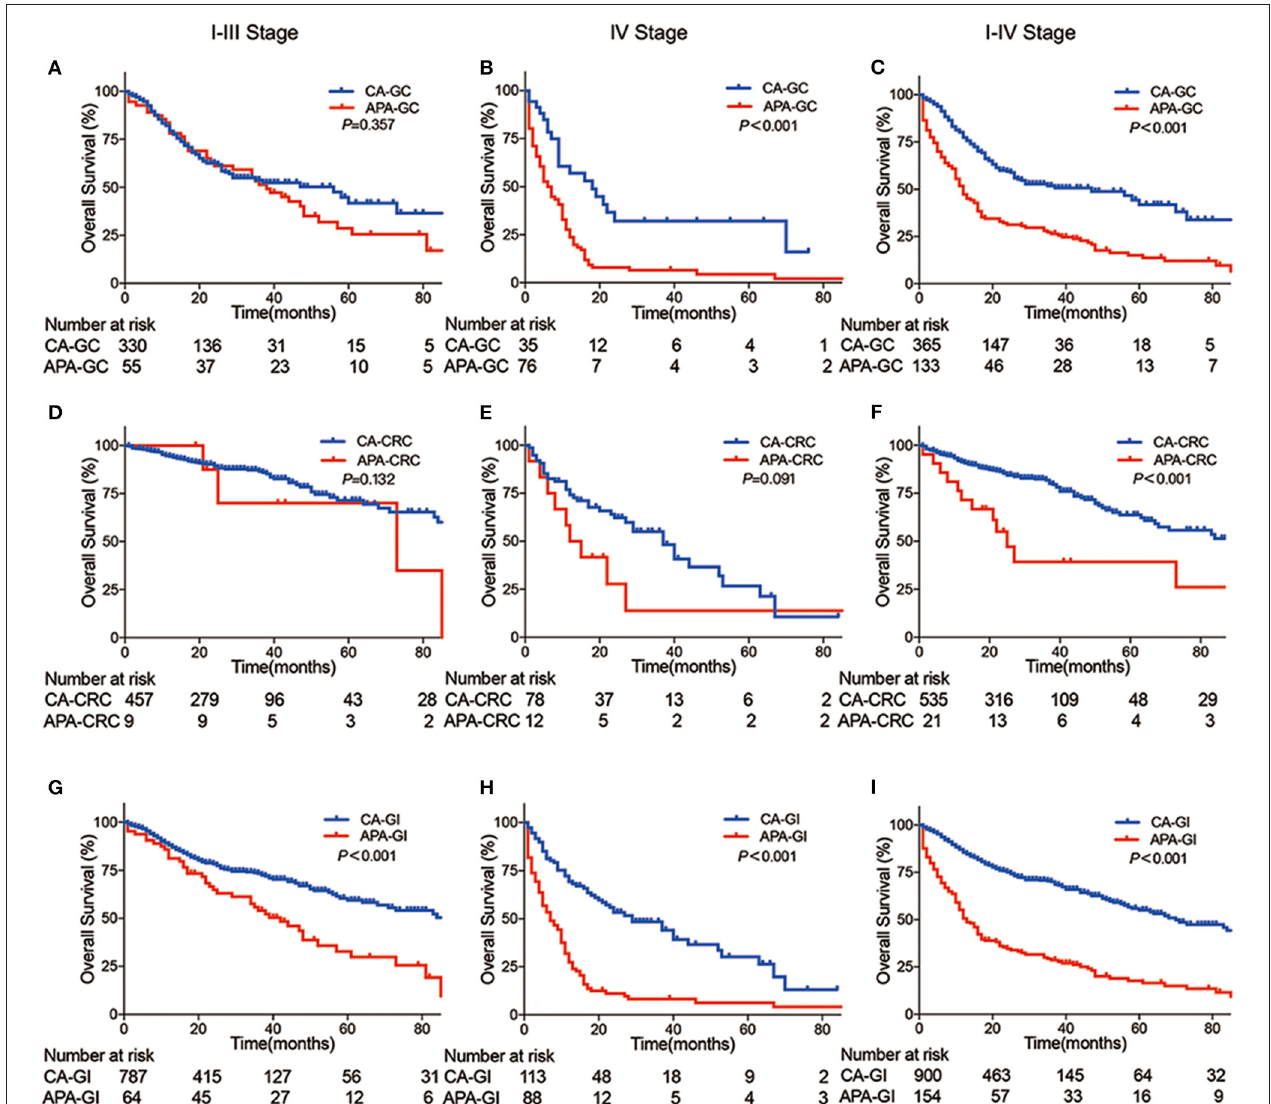
FIGURE 2 | Kaplan–Meier curve between APA-GI and CA-GI. (A–C) Survival differences between APA-GC and CA-GC; (D–F) survival differences between APA-CRC and CA-CRC; (G–I) survival differences between APA-GI and CA-GI; Column 1 shows survival comparison between stages I–III patients. Column 2 shows survival comparison between stage IV patients. Column 3 shows survival comparison between stages I–IV patients. APA-GI patients were composed of 154 APA-GC and APA-CRC from the SAHZU database, whereas CA-GI patients were all extracted from TCGA database. Notably, two APA-GC patients were unable to perform accurate staging due to the lack of medical imaging data. Therefore, they can only be classified as stages